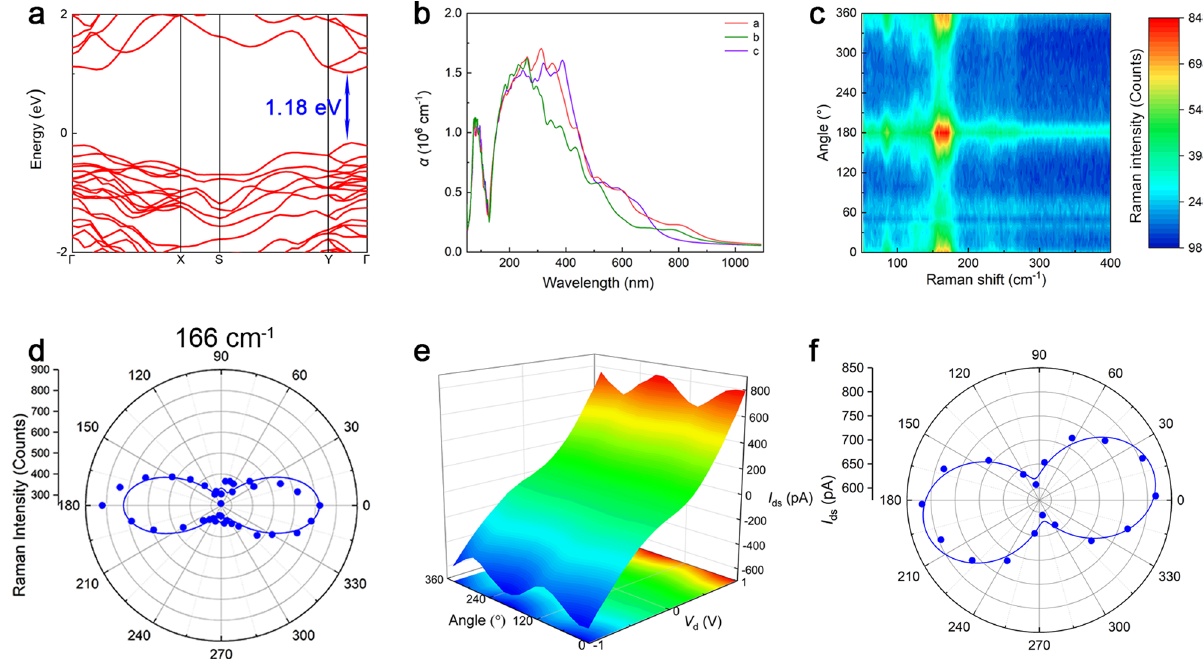
Fig. 2 Material characterization and the polarized optoelectronic response of Bi 2 Se 2 S NW-based PS. a The band structure of the bulk Bi 2 Se 2 S calculated by the HSE06 functional. b Calculated optical absorption coef fi cients α ( ω ) of Bi 2 Se 2 S along the a, b, and c axes. c The angle-resolved Raman scattering spectra under parallel con fi gurations of 532 nm laser. d Polar plot of Raman peaks at 166 cm − 1 belonging to the Ag mode under parallel con fi gurations of 532 nm laser. e Current-voltage ( I - V ) curve under 638 nm (optical power density of 111.368 mW/cm 2 ) with different polarization angle. f Polar diagram of the relationship between photocurrent and polarization angle under 638 nm at 1.0 V drain bias, the anisotropic photocurrent ratio is